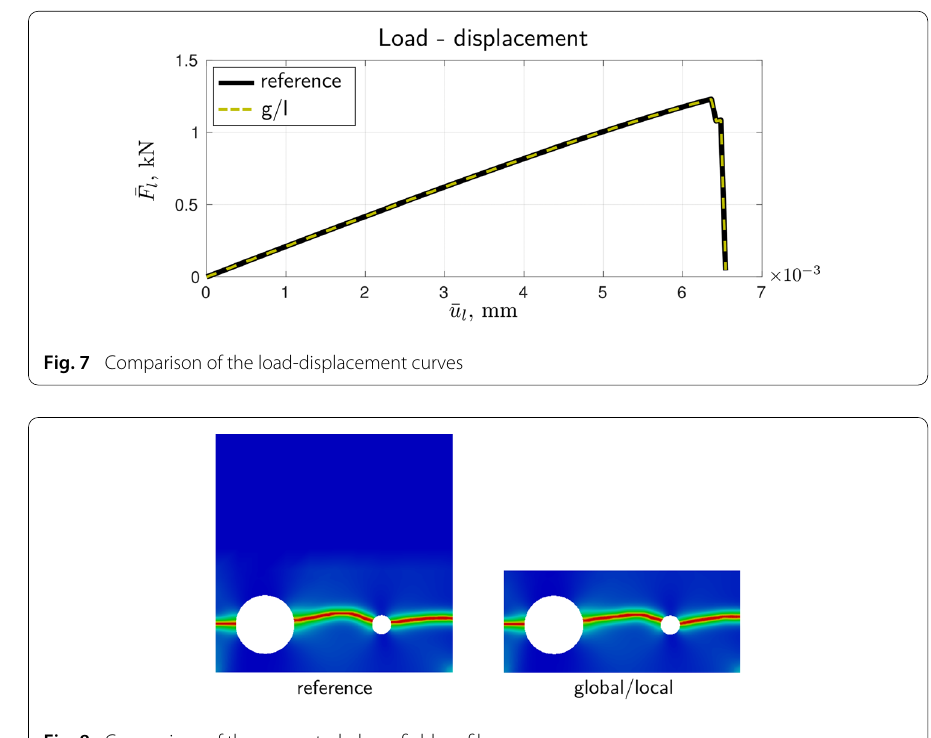
Fig. 8 Comparison of the computed phase-field